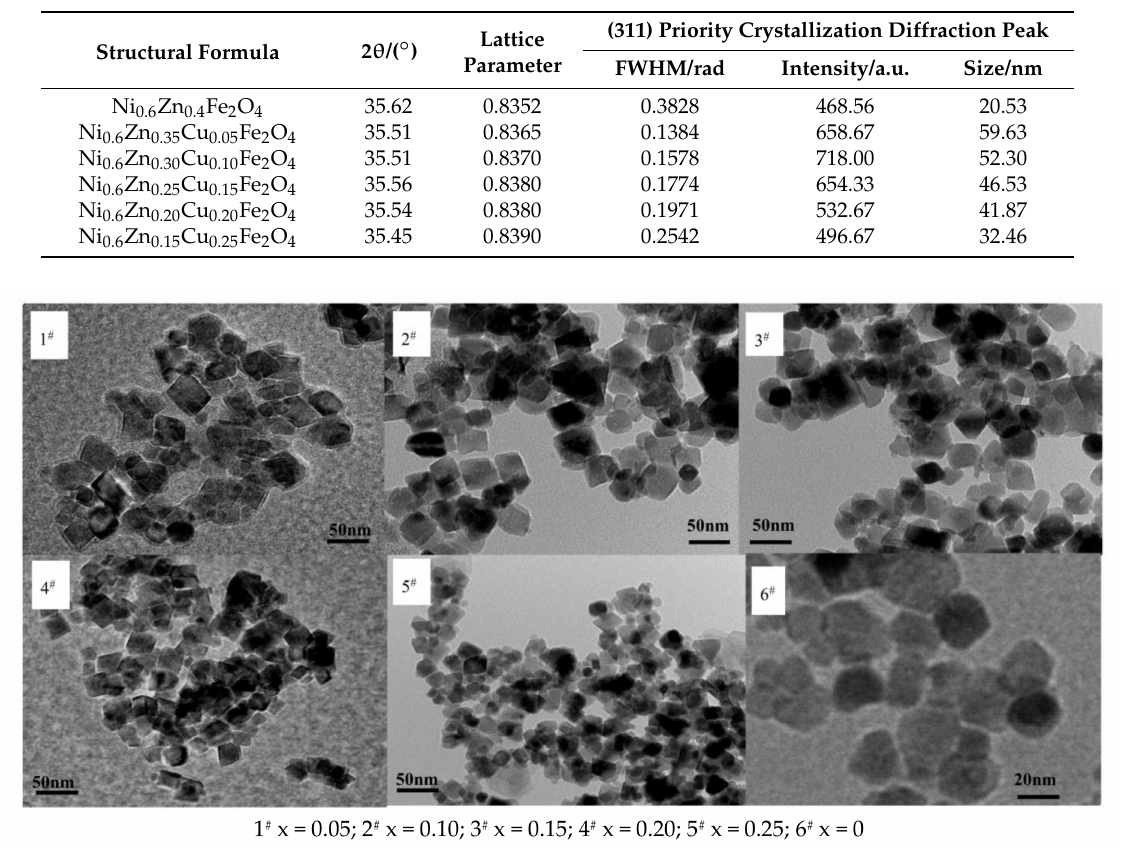
Figure 10. Transmission electron micrograph of samples prepared with different Cu 2+